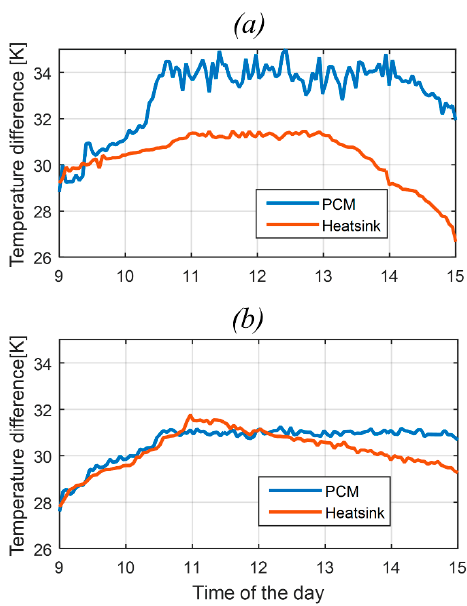
Figure 14. Temperature gradient during the day ( a ) with a radiation over the average ( b ) with a radiation below the average. Table 5. TEG expected power and energy based on temperature gradient measurements.